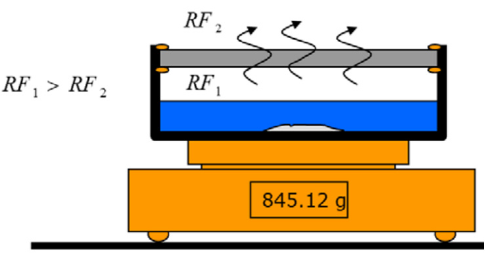
9 of 26 Figure 5. Mechanical thickness measurements of a sample using a dial gauge from Sylvac. 2.4.5. Water Vapor Diffusion Resistance Water vapor diffusion resistance was determined using a cup sealed with a lid con- sisting of a test membrane, see Figure 6. A saturated saline solution (KNO 3 ) inside the cup ensures a constant relative humidity of 93% ( RF 1 ). The cups were placed in a climate cham- ber at 23 ± 1 °C and 50 ± 2% RH ( RF 2 ). The lid area was 0.00785 m 2 . The lid area was identical to the size of samples. The water vapor flux was found by recording the weight change over time. As the moisture flow stabilizes, a straight line is recorded. The slope of the curve was determined describing a constant moisture flow. The flux through a membrane at a given time can be determined from: